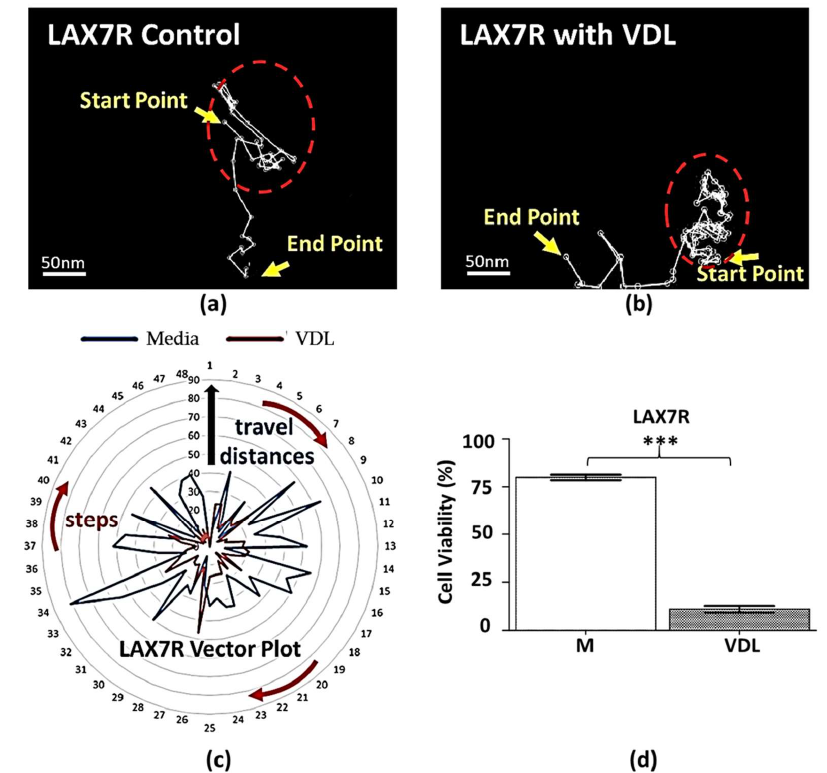
Figure 2. An example of LAX7R co-cultured with HS27a human stromal cells monitored by time-lapse microscopy to display the motility tracks of viable primary B-ALL cells in control medium and treated with chemotherapy. ( a , b ) illustrate a case of a LAX7R cell migration pattern (white lines) in medium control and with VDL chemotherapeutical treatment for 7 days. The time-lapse image reveals that the migration pattern is tangled at the start point of the migration and displays a weak motility as the cells were treated with VDL (red-dashed circles). The scale bars in ( a , b ) are 50 nm. ( c ) A proposed vector plot provides a visualization to simultaneously observe cell motility and migration patterns in both medium and VDL. The arc (red arrows) and radial (blue arrow) indicate a cell’s migration steps and travel distance from its start point. In the study, the 48 steps (12 h recording) were considered in both groups. The travel distance to 90 indicates 26.1 µm as the actual distance. ( d ) The viability of the medium control and VDL-treated cells on Day 7 was measured by 7-AAD and Annexin V-PE staining using flow cytometry. *** p < 0.001 compared with the medium group, unpaired t -test. The letter M stands for medium.